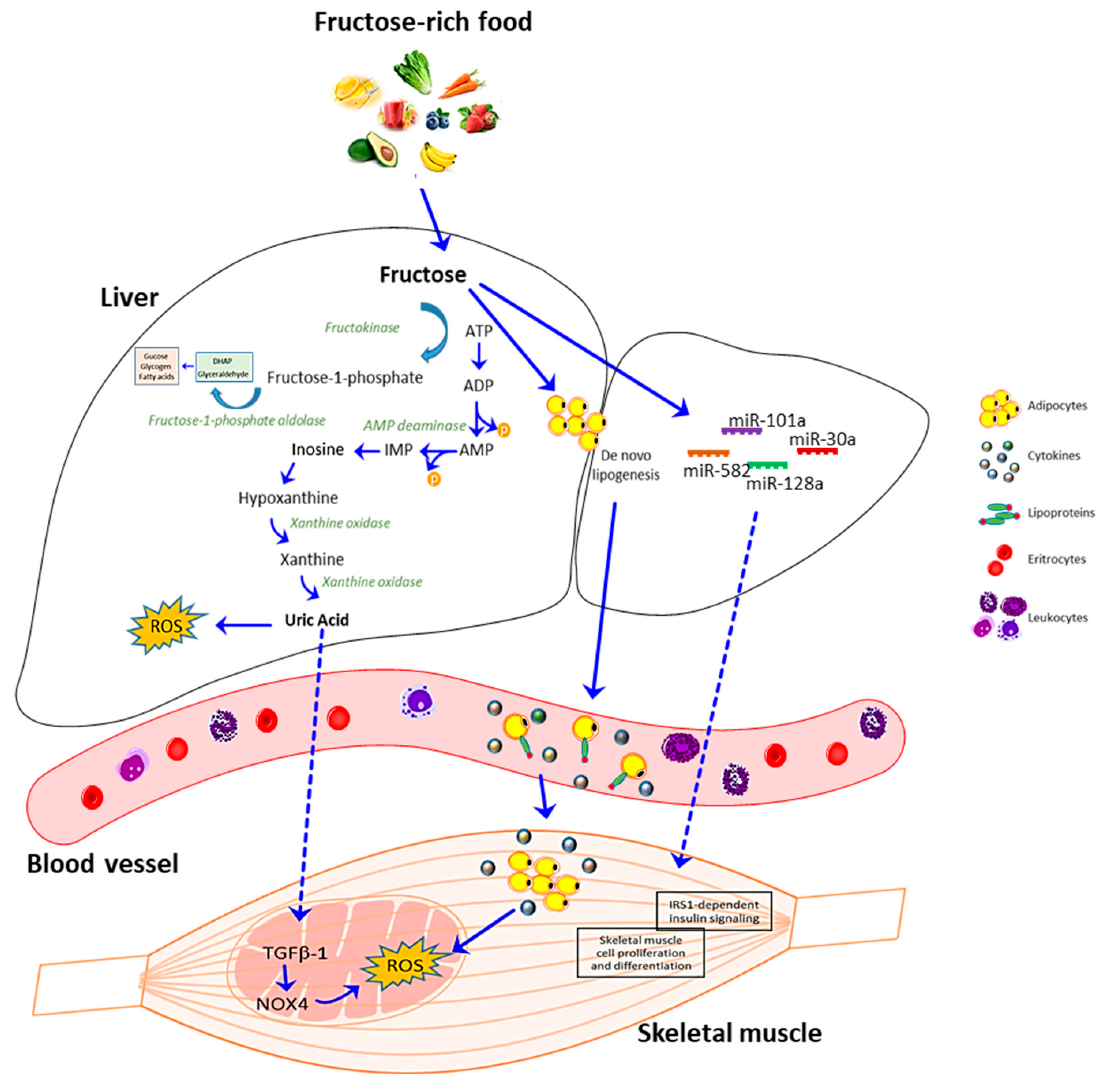
Figure 3. Schematic representation of fructose metabolism and uric acid e ff ect on skeletal muscle. In the liver, fructose is phosphorylated into fructose 1-phosphate by fructokinase in a reaction that decreases the levels of intracellular phosphate and ATP. Subsequently, the enzyme fructose-1-phosphate aldolase gives rise to dihydroxyacetone phosphate (DHAP) and glyceraldehyde. When fructose 1-phosphate accumulates, intracellular phosphate decreases, stimulating AMP deaminase, which catalyzes the degradation of AMP to inosine monophosphate (IMP). IMP is metabolized to inosine, which is further degraded to xanthine and hypoxanthine by xanthine oxidase, ultimately generating uric acid (UA). UA can induce ROS production in the liver and other tissues, such as skeletal muscle via TGF β -1-NOX4 signaling. Alternatively, fructose can stimulate de novo lipogenesis in the liver with increased release of lipids and lipoproteins in the bloodstream that are then uptaken by di ff erent tissues including skeletal muscle, with consequent cytokines and ROS production. Besides, high levels of fructose can modulate the expression of miRNAs that may a ff ect skeletal muscle cell proliferation, di ff erentiation, and insulin